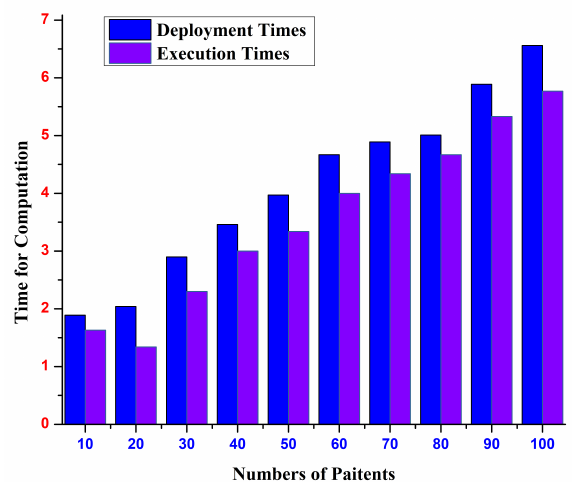
Figure 6. ML-based blockchain execution and deployment of smart